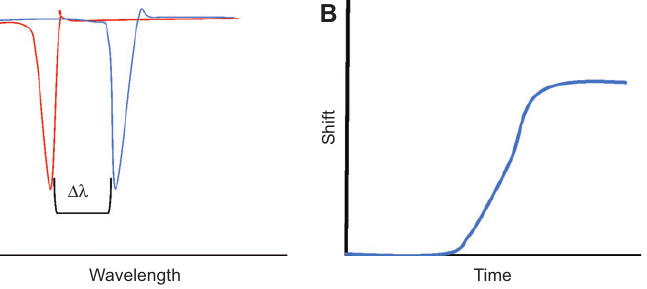
Figure 10 Output graphs of WGM microsphere resonators. (A) Diagram of a shift in the resonant wavelength due to ligand-protein binding. (B) Output graph of shift vs. time during protein-ligand binding, which can be used to define the kinetic parameters of the binding interaction. in the surrounding environment, and when one attaches to the surface, the resonant frequency of the optical field circulating around the device shifts due to changes in the field’s effective refractive index (Hunt and Armani 2010) (Figure 9). For instance, an increase in the effective refrac- tive index of the optical field will red-shift the resonant wavelength (Figure 10A). The resonant wavelength of a given cavity is defined as a wavelength λ for which the resonator’s circumference is an integer number of wave- lengths [Eq. (7), where R = radius].